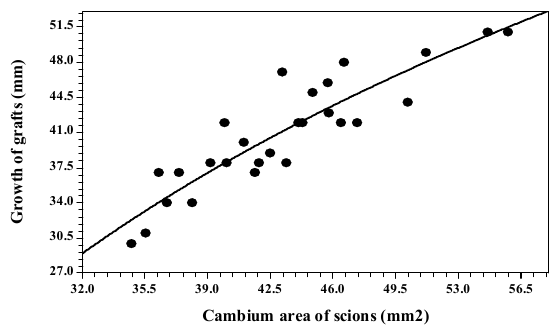
Figure 5. Scatter plot of the fit of the logarithmic model that was used to predict the longitudinal growth of grafts as a function of the cambium area on the scion (CAS).